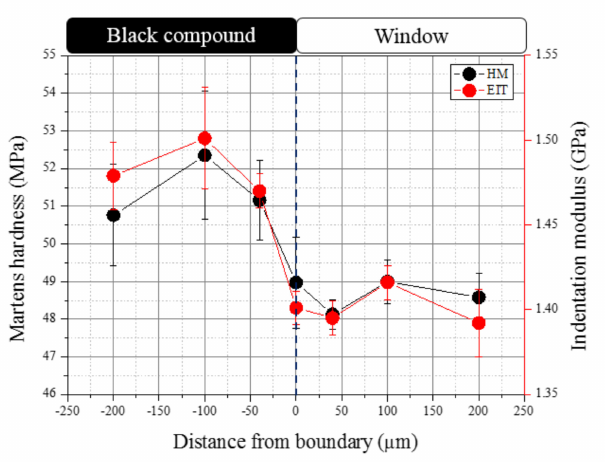
Figure 22. Variation of HM and EIT with distance from the windows–black compound